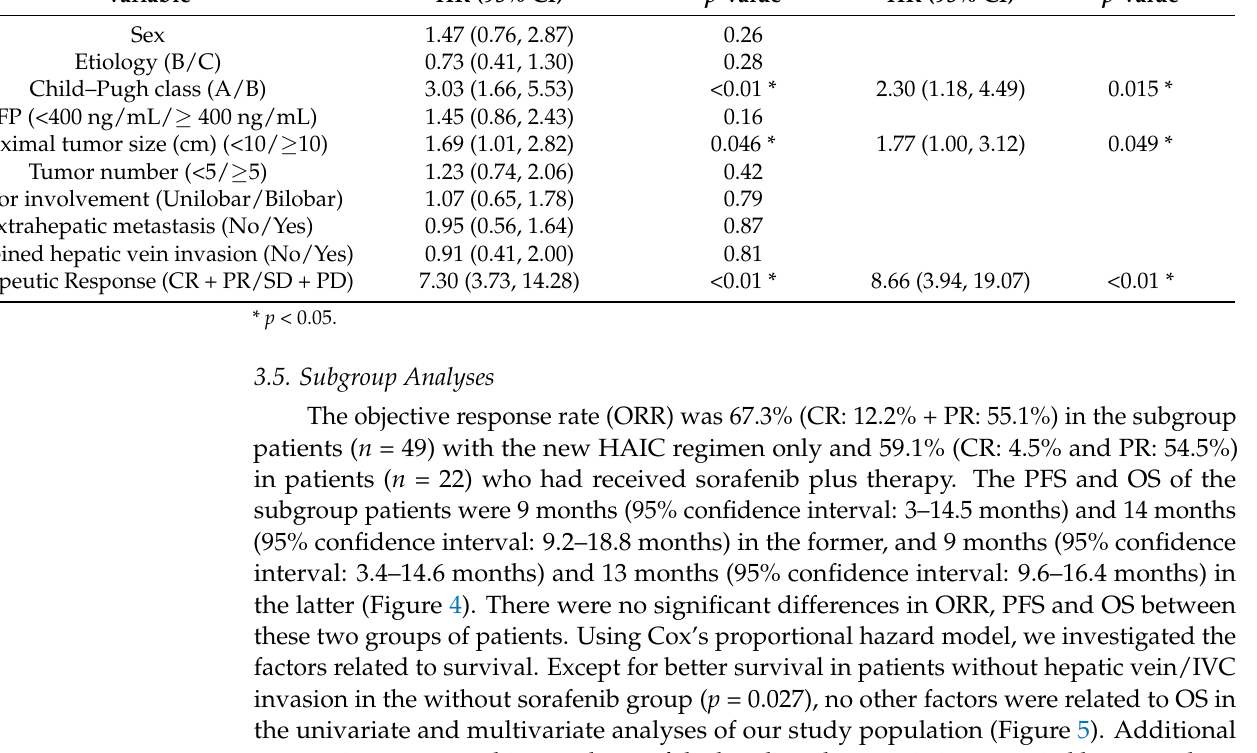
Table 3. Univariate and multivariate analysis of the hazard risk on OS of the 71 Vp4 patients. Univariate Analysis Multivariate Analysis